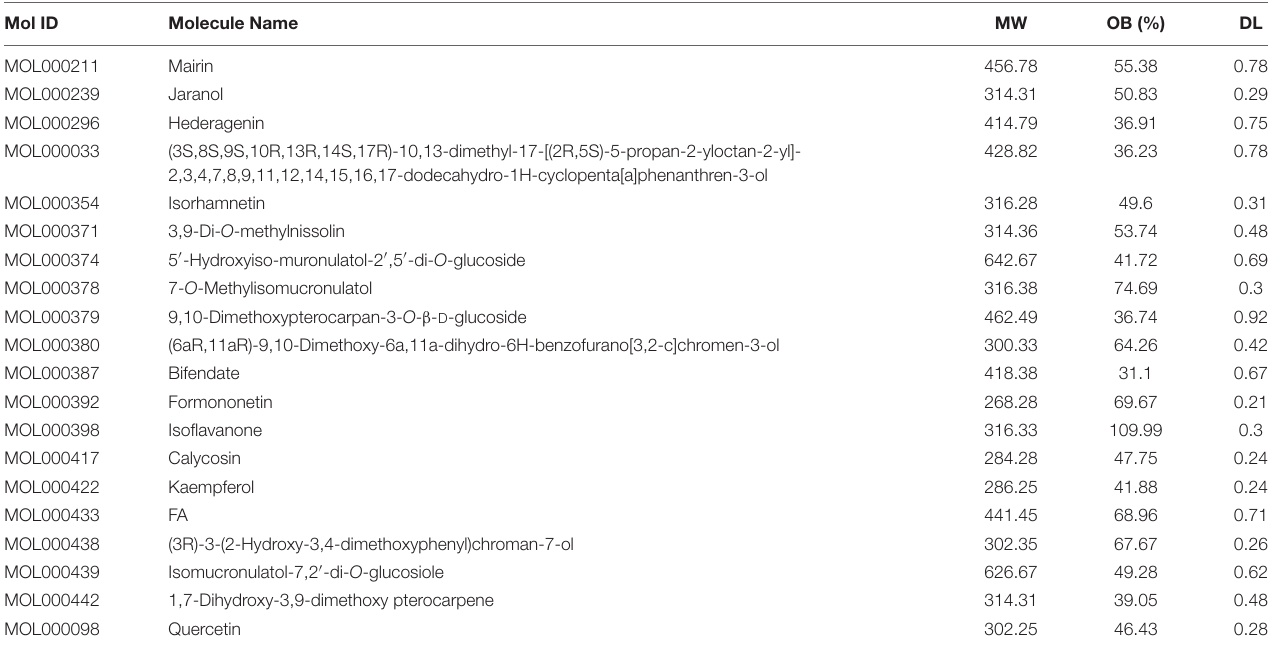
TABLE 1 | Components in Astragali Radix